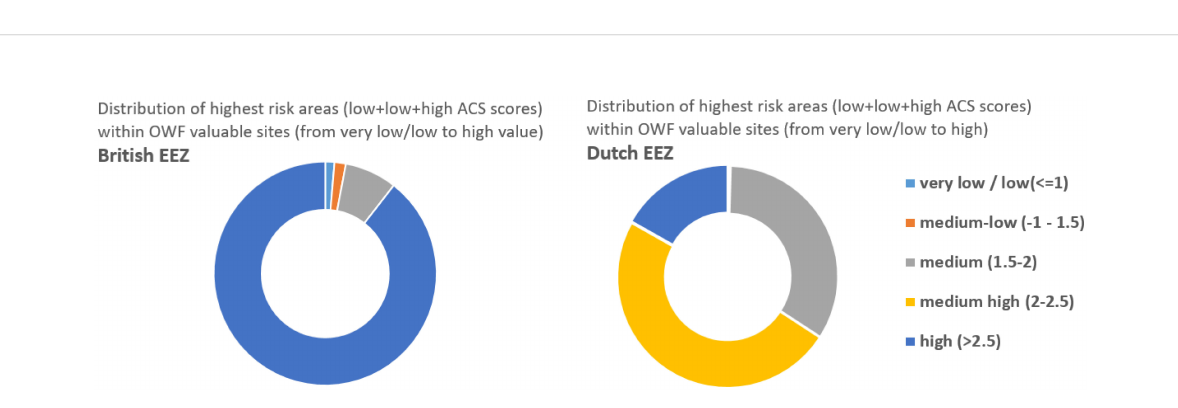
FIGURE 20 Distribution of highest risk areas for shipping activities within the OWF sites for the Dutch and English EEZ.